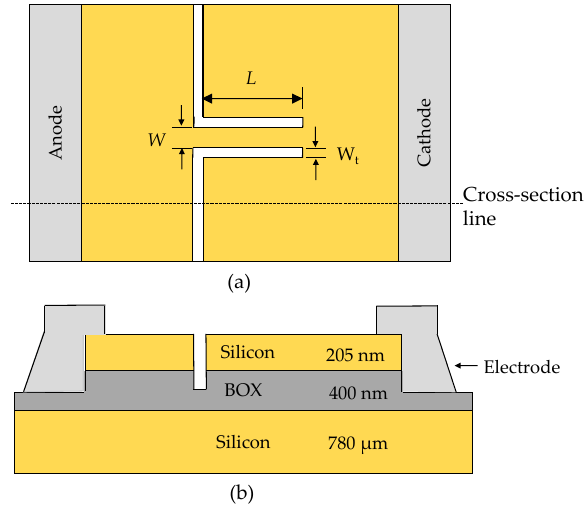
Figure 1. ( a ) Structural parameters of an SOI-based SSD, showing three main control factors: L , W , and W t , and ( b ) the cross-section of the device.